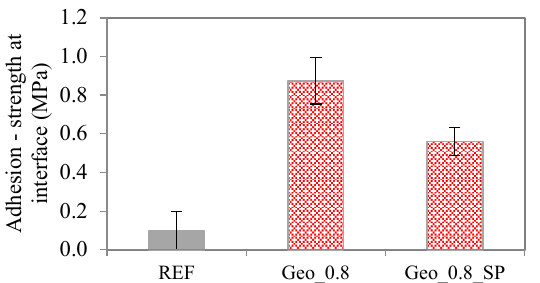
Figure 8. Adhesion strength values at interface between grout and porous